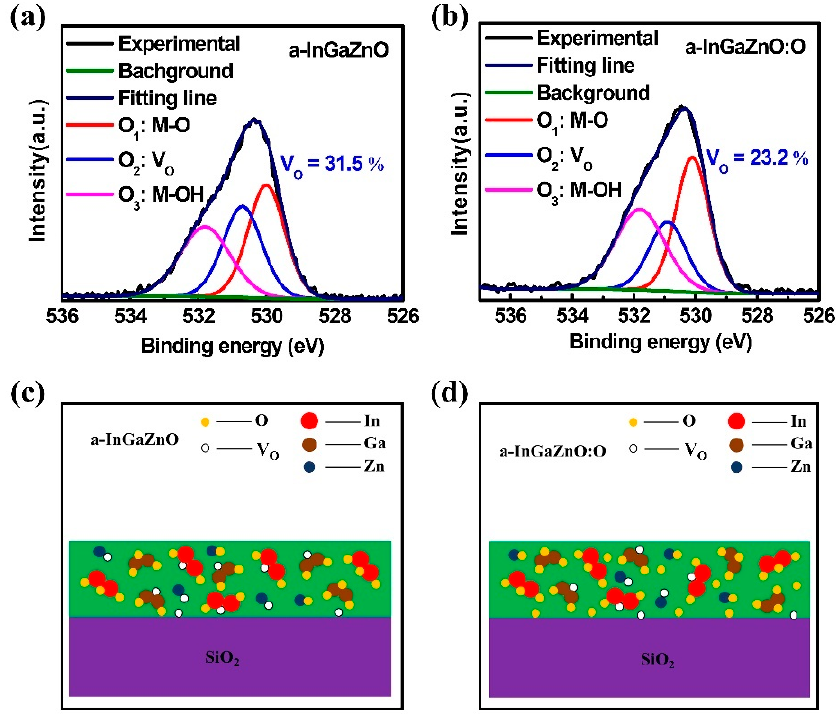
Figure 7. XPS spectra of O 1s in ( a ) a-InGaZnO film and ( b ) a-InGaZnO:O film; Schematic diagram of V O changes in ( c ) a-InGaZnO film and ( d ) a-InGaZnO:O film. Table 4. Comparison of preparation parameters and electrical properties of various a-InGaZnO TFT deposited by